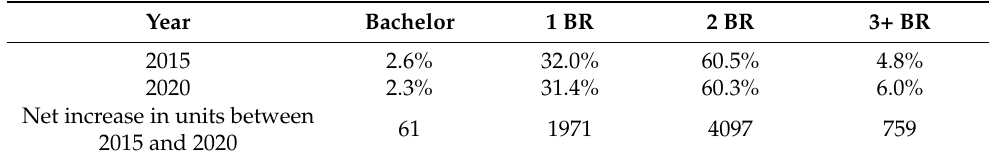
Table 1. Rental apartment unit supply